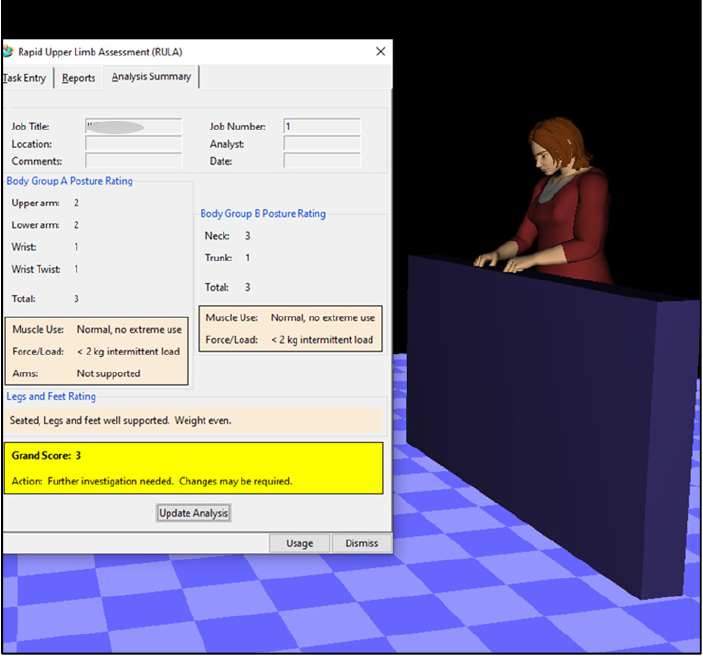
Figure 8. Simulation by Jack—Siemens ® trial version and respectively RULA assessment.